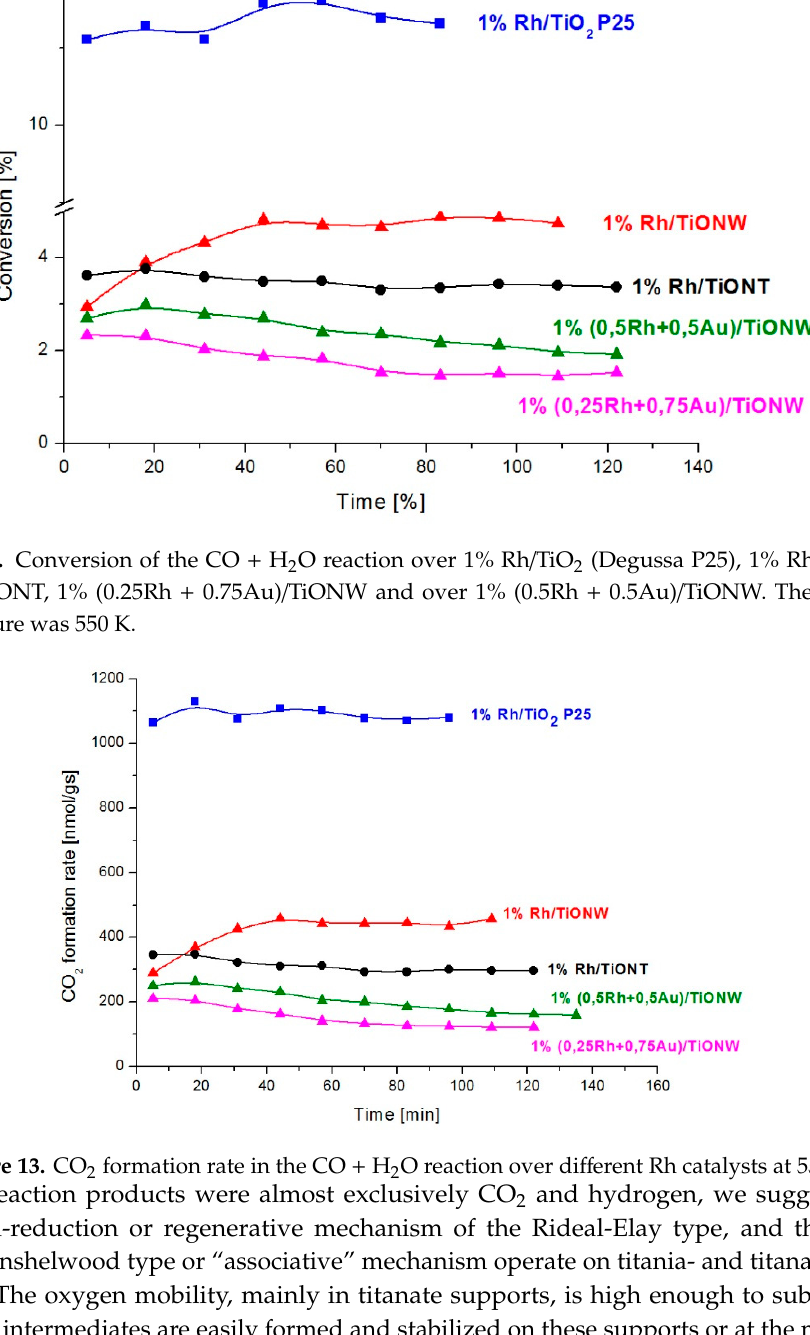
Figure 13. CO 2 formation rate in the CO + H 2 O reaction over different Rh catalysts at 550 K.